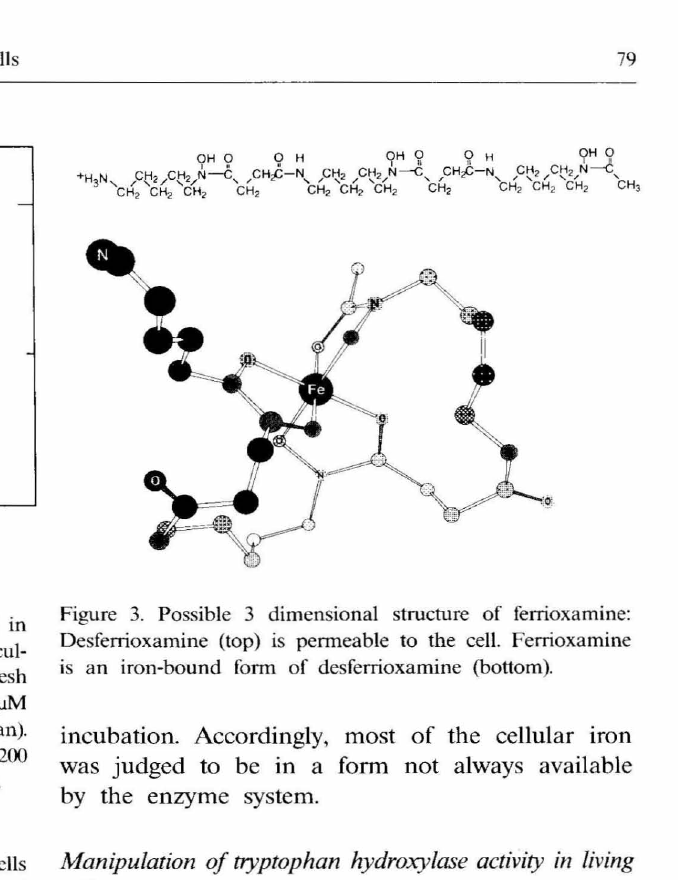
Table 2. Tryptophan hydroxylase activity of RBL2H3 cells in monolayer culture: Two different assays were performed and compared. Cell-free enzyme activity was measured with disrupted cells after freezing and thawing. Cellular activity was taken as the accumulation of 5HTP in the presence of 200 !-1M NSD-1055 for 40 min.